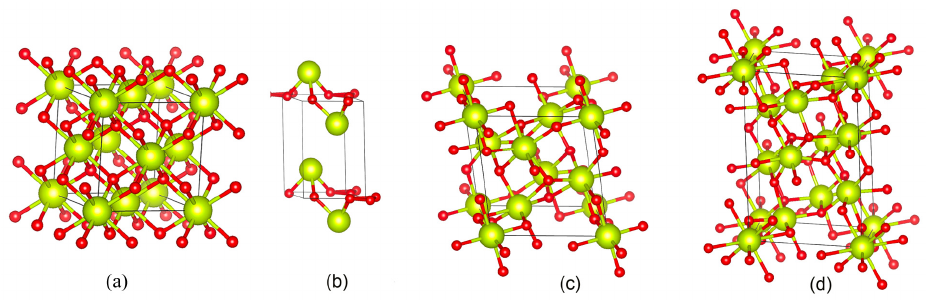
Figure 4. TEM image of nanoceria extracted from S5NBCe4 glass by dissolving in DI water for two hours. The marked crystals and their width is shown in the figure.